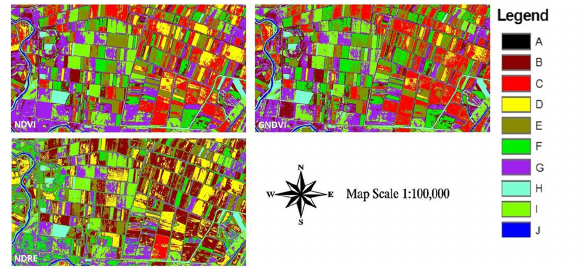
Figure 3.Single-band image